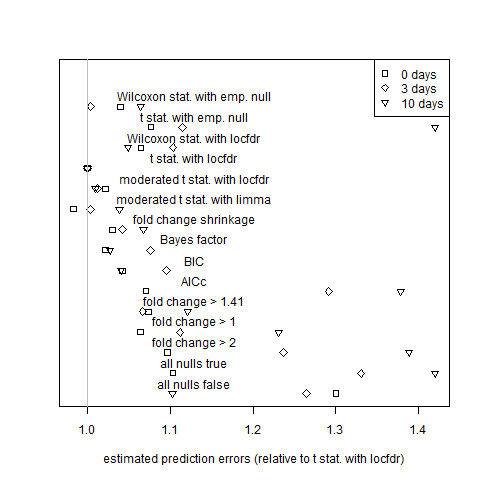
Assessment of estimator performance by cross validation for the paired tomato data sets. Average estimated prediction error, defined by equation (34) and based on cross validation, at the breaker stage of ripening (squares), 3 days after ripening (diamonds) and 10 days after ripening (triangles). The values of α displayed correspond to the gene selection algorithms of equations (1)-(7).